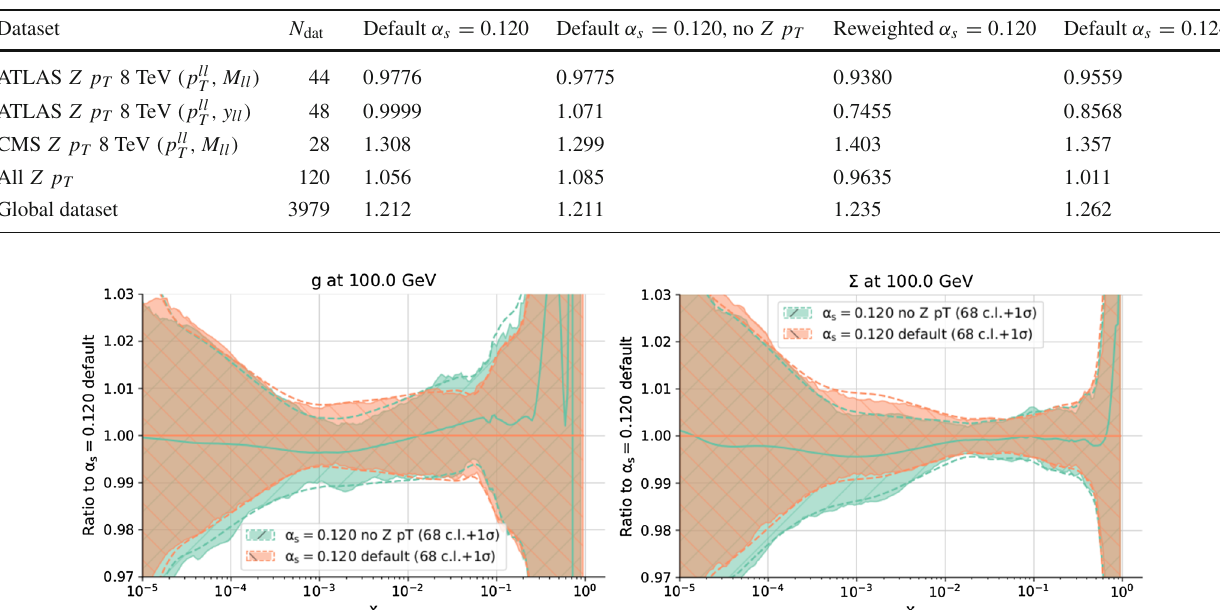
Table 2 Same as Table 1, but now comparing the values of χ 2 / N dat for the Z p T distributions and the global dataset. The values for the global dataset are the same as in Table 1, while the values for the total